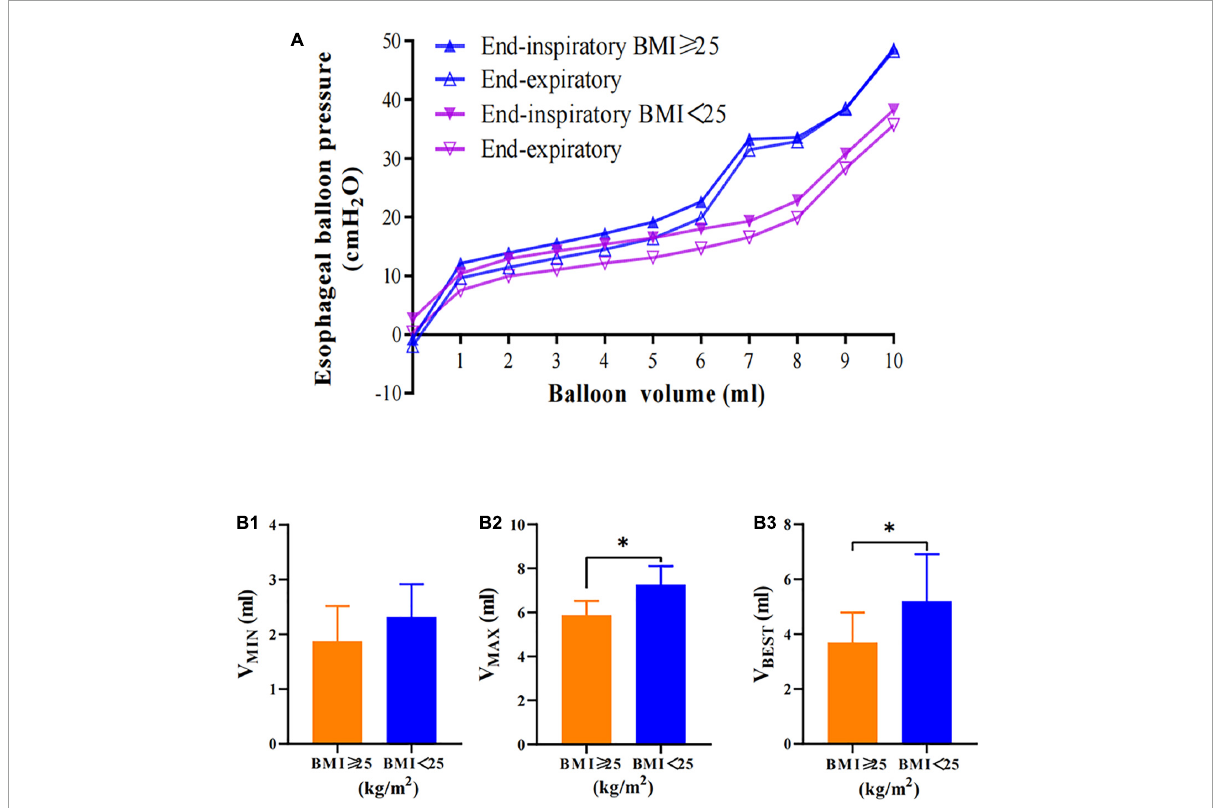
FIGURE4 Esophageal balloon pressure-volume curves of different BMI groups. (A) Relationship between balloon filling volume and values of Pes in the BMI ≥ 25 kg/m 2 (Pes EI , solid blue triangle; Pes EE , hollow blue triangle) and BMI < 25 kg/m 2 (Pes EI , solid purple triangle; Pes EE , hollow purple triangle) groups. Patients in the BMI < 25 kg/m 2 group had lower Pes than those in the BMI ≥ 25 kg/m 2 group. (B) Patients in the BMI < 25 kg/m 2 group had higher balloon volume than those in the BMI ≥ 25 kg/m 2 group. * P < 0.05 compared with the BMI ≥ 25 kg/m 2 group. Pes: esophageal